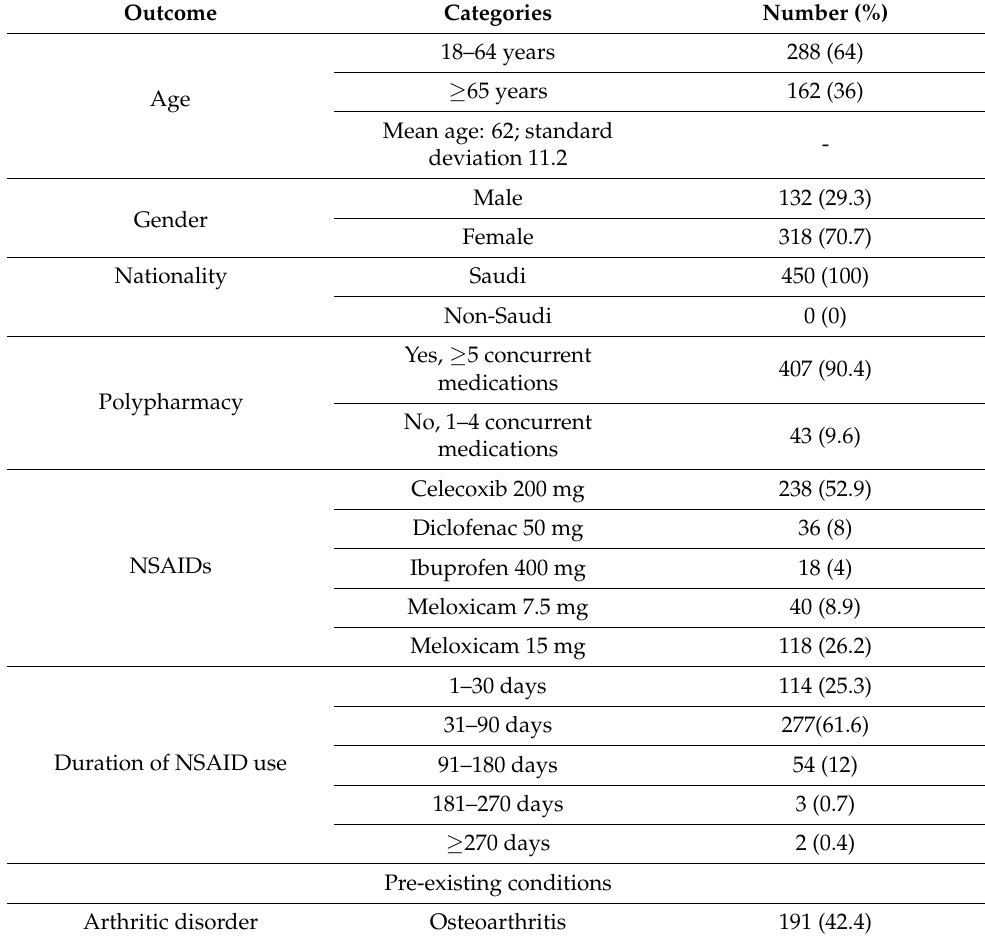
Table 1. Demographic